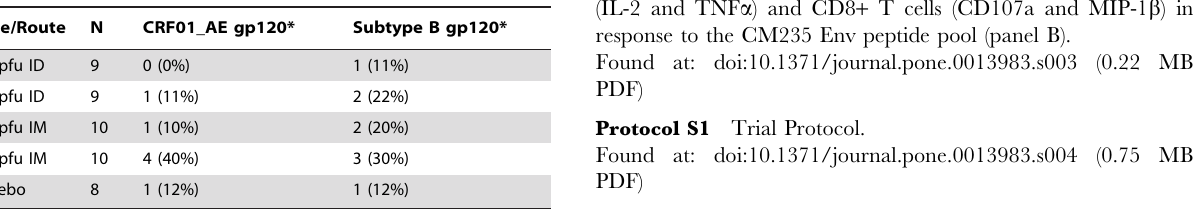
Figure S1 Cumulative CD8-dependent CTL responses. Cumu- lative responses determined by the 51 Cr-release assay are shown for HIV-specific (any Env/Gag/Pol) responses (panel A) and for vector-specific (MVA) responses (panel B). The y-axis represents the cumulative response rate in percentage for each route and dose, while the time post-vaccination initiation (days) is shown on the x-axis. Red arrows denote the timing of the vaccination series. Found at: doi:10.1371/journal.pone.0013983.s001 (0.03 MB PDF) Figure S2 Quantitative IFN c Elispot responses for all doses and routes. Elispot counts are shown for the total peptide response (Env plus Gag plus Pol responses; panels A and B), for the Env peptide response (panels C and D) and the Gag peptide response (panels E and F). Panels A, C and E show the intra-muscular vaccination responses, while panels B, D and F show the intra- dermal vaccination responses. The y-axis represents the magni- tude of the response (IFN c SFC/10 6 PBMC), while the time post- vaccination initiation (days) is shown on the x-axis. Data is presented as corrected values (test article - background). The dotted line (27 SFC/10 6 PBMC) represents the limit of detection for the validated ELISPOT assay and the red arrows denote the timing of the vaccination series. Found at: doi:10.1371/journal.pone.0013983.s002 (0.10 MB PDF) Figure S3 Gating strategy applied to the multifunctional flow cytometric analyses. A representative sample is shown for the gating strategy used for viable, CD3 + lymphocyte identification and subsequent subdivision into CD4 + and CD8 + T cells (panel A). A functional positive response is shown for both CD4 + T cells (IL-2 and TNF a ) and CD8 + T cells (CD107a and MIP-1 b ) in response to the CM235 Env peptide pool (panel B). Found at: doi:10.1371/journal.pone.0013983.s003 (0.22 MB